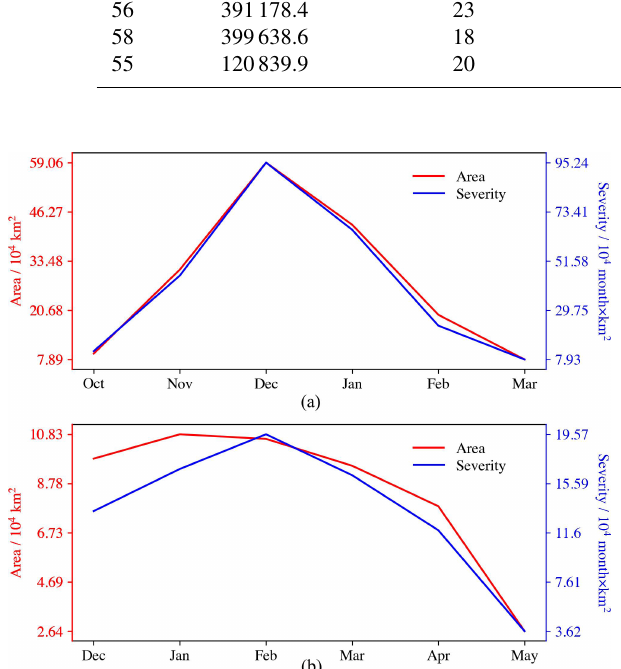
Figure 7. Temporal evolution of severity and area of (a) meteo- rological drought event No. 87 and (b) ecological drought event No.